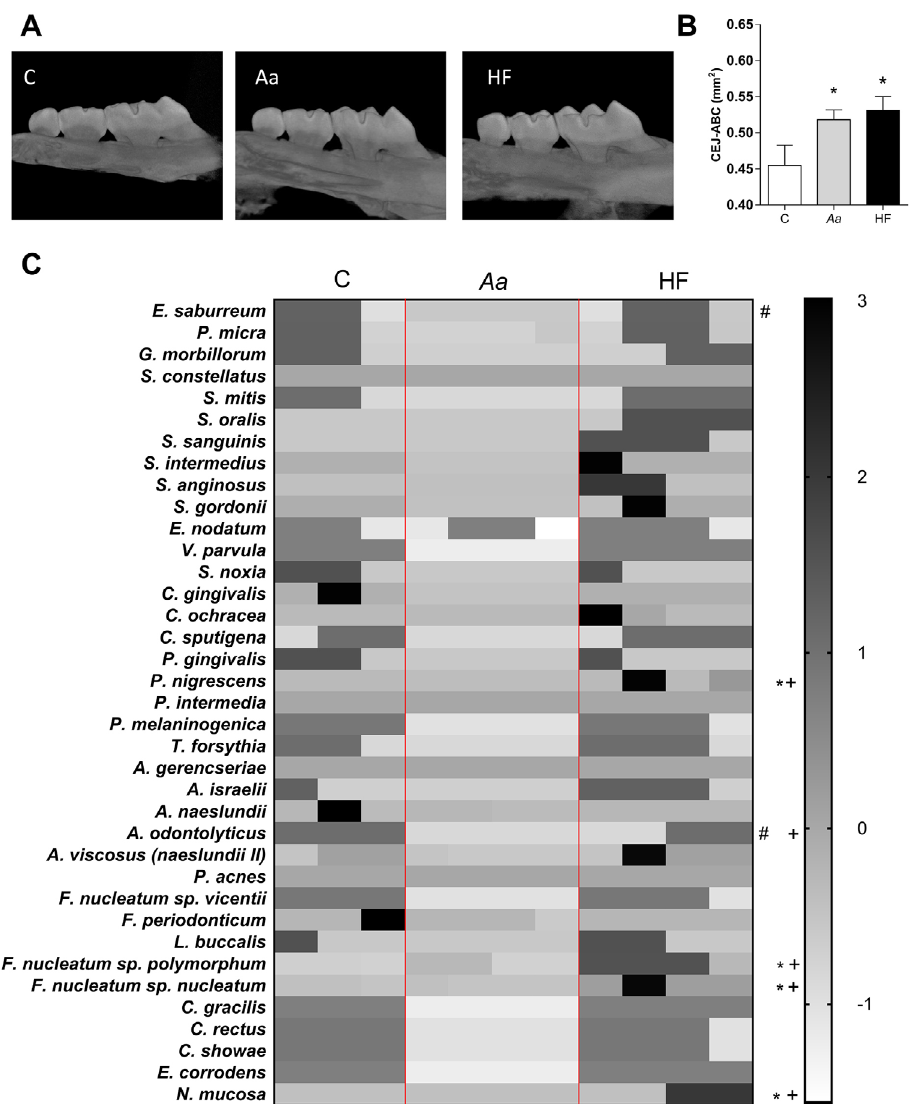
Figure 3- Analysis of periodontal tissues of infected or sham-infected mice subjected to the control or HF diets. (A) Representative images of hemimaxillae of mice from different experimental groups. (B) Analysis of alveolar bone loss after 12 weeks with diet and 4 weeks after oral inoculation of A. actinomycetemcomitans . The values (mean ± S.E.M) were obtained from 5 - 7 animals at each point in two independent experiments, with a total of 35 mice. *p<0.05 when compared to control. One-way ANOVA followed by Newman-Keuls. (C) Heat-map representing differences on the oral microbiota analysis between mice fed with the control diet infected or non-infected with Aa , and non-infected mice fed with the HF diet. Groups: C — Sham-infected group on the control diet. Aa — Group on the control diet, infected with A. actinomycetemcomitans HF — Group on the HF diet, non-infected. N=5. *p<0.05 Aa compared to HF; #p<0.05 C compared to Aa ; +p<0.05 C compared to HF. A two-way ANOVA — Bonferroni multiple comparison test was performed. The values (mean ± S.E.M)